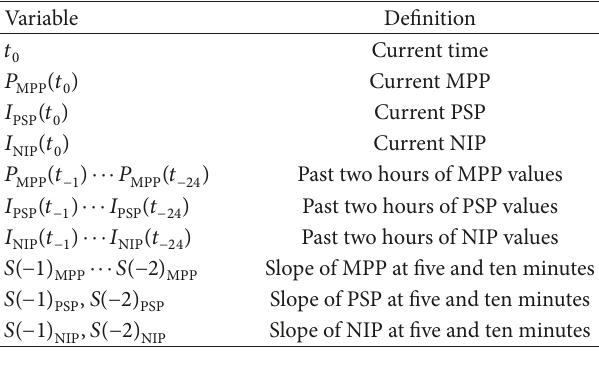
Table 2: ANN assessments from the related literature. Assessment